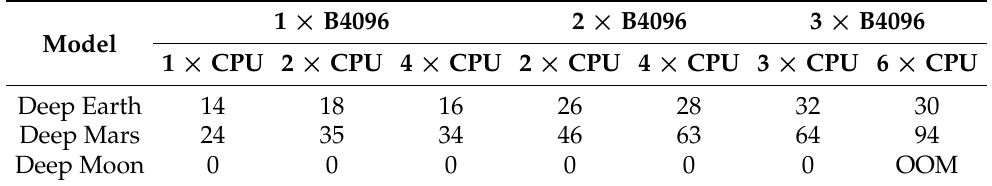
Table 17. Multi-Stream benchmark results (max number of streams) for B4096 DPU